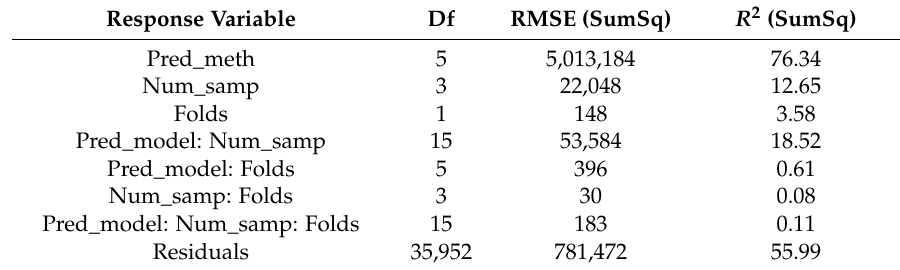
Table 1. Results of analysis of variance (ANOVA) conducted to explain the variance of R 2 and root mean square error (RMSE) obtained from different